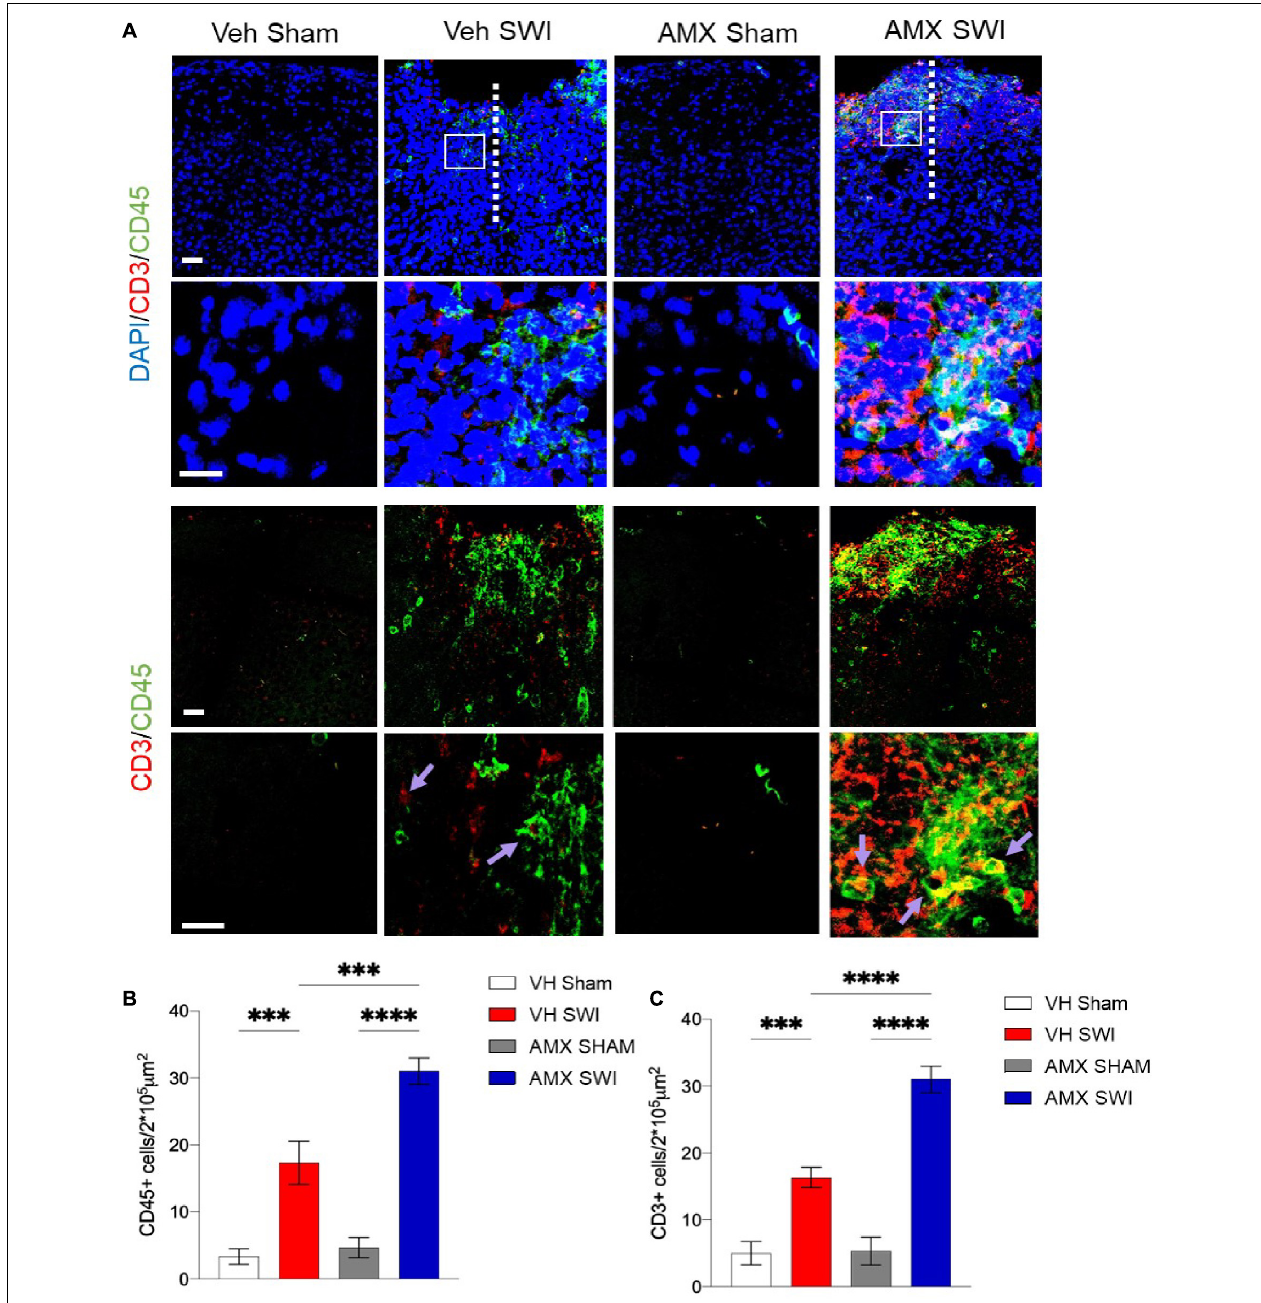
FIGURE 4 | Tbk1 blockade enhances infiltration of the Stab Wound Injury (SWI) by peripheral immune cells. (A) In AMX-treated animals (at 7 dpi), the SWI site displayed a substantial increase in the density of CD45-bright cells including peripheral leukocytes; quantified in (B) and lymphocytes CD3 + cells; quantified in (C) ; average ± SD; two-way ANOVA with Tukey’s post hoc ( n = 3 animals/group with 4 sections/animal. ∗∗∗ p < 0.001, ∗∗∗∗ p < 0.0001; full statistical report in Supplementary Table 6 ). Upper panel, low magnification; insets at high magnification. Scale bars (both sets of panels) 200 µ